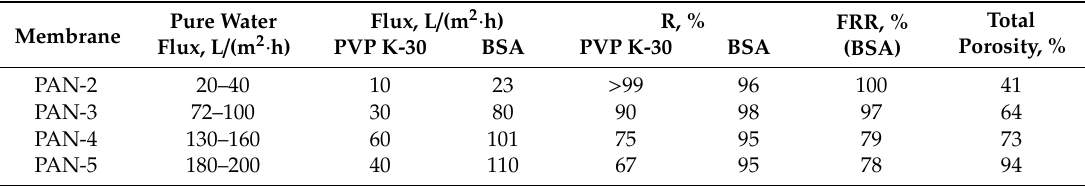
Table 2. PAN membrane performance in ultrafiltration of PVP K-30 and BSA solutions and total membrane